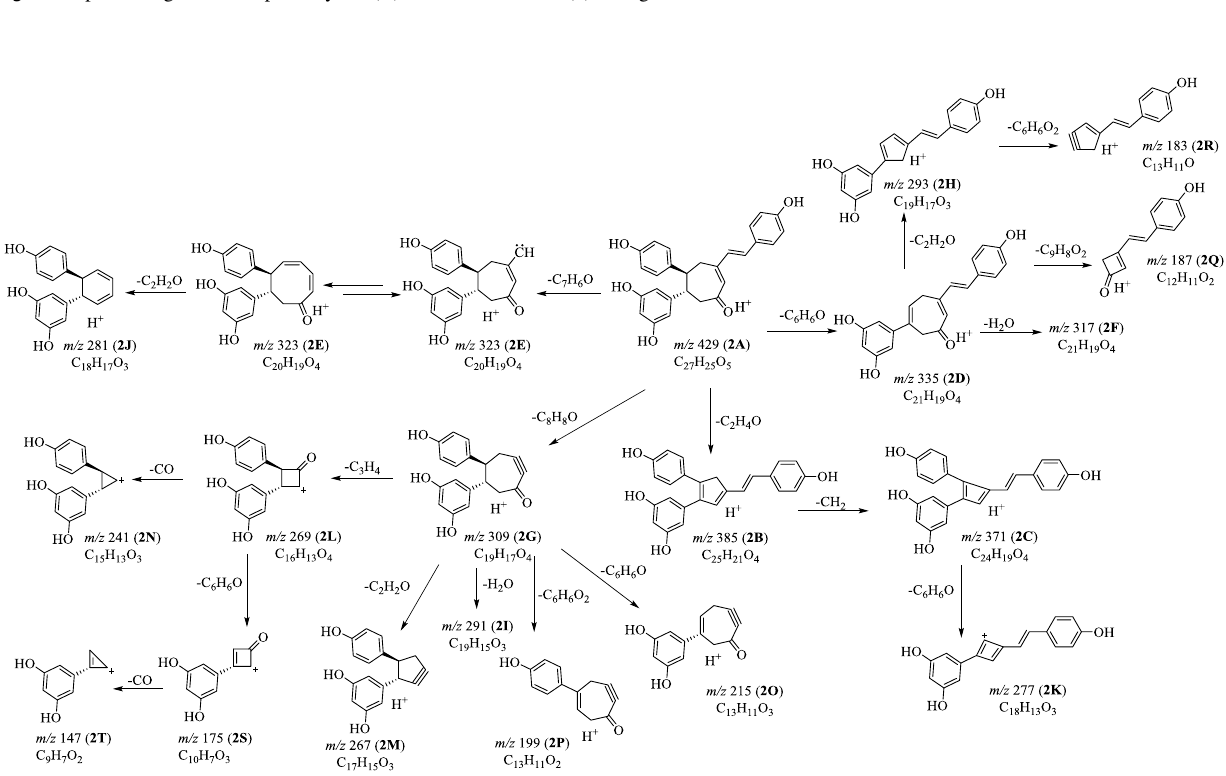
Fig. 4 Proposed fragmentation pathways of carasiphenol A ( 2 ) in positive